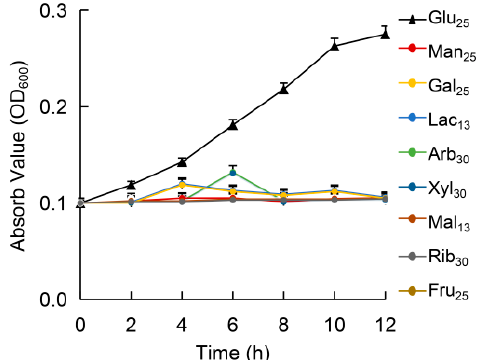
Figure 1. Growth of Pseudomonas stutzeri A1501 in a minimal medium containing different sugars with the same number of carbon atoms (glucose, 25 mmol/L; mannose, 25 mmol/L; galactose, 25 mmol/L; lactose, 13 mmol/L; arabinose, 30 mmol/L; xylose, 30 mmol/L; maltose, 13 mmol/L; ribose, 30 mmol/L; and fructose, 25 mmol/L). The values are the means of three independent experiments. Error bars represent the standard deviation (SD) of the three biological replicates from a single experiment. For some data points, the SDs were smaller than the symbol size, so the error bars are indiscernible.